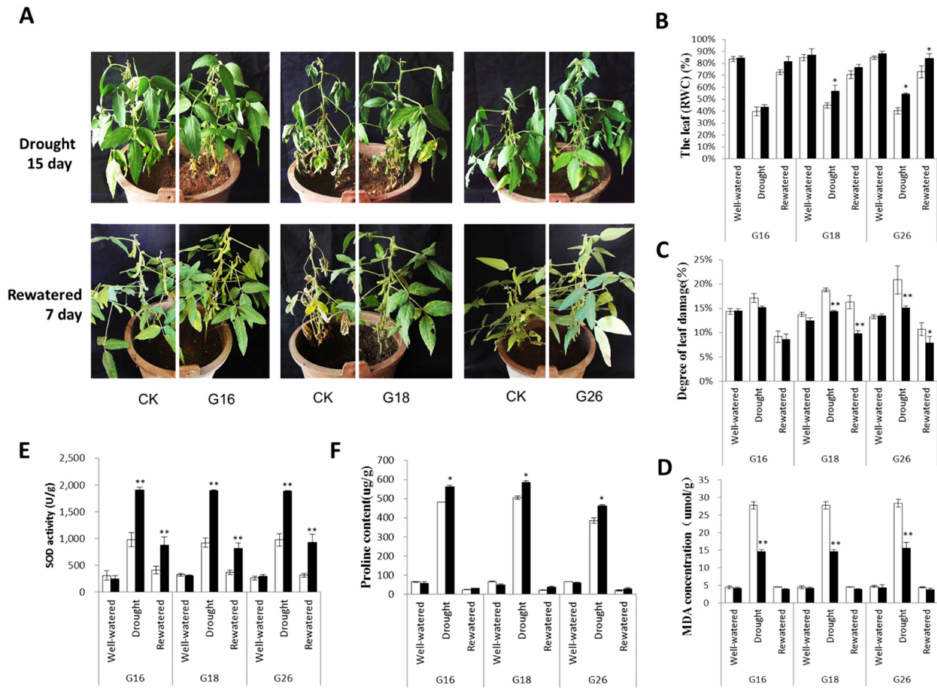
Figure 5. The GmNFYB17 transgenic soybean lines under drought treatment. ( A ) Morphology of transgenic and non-transgenic plants under drought conditions. Water was withheld for 15 d, and then plants were re-watered for 7 d. G16, G18 and G26 are transgenic lines; CK is soybean DN50; ( B , C )The leaf relative water content (RWC) and leaf damage of transgenic lines. G16, G18, G26 and non-transgenic control (CK) during the well-watered, drought and re-watered stage; ( D – F ) Comparison of physiological and biochemical indicators (MDA, SOD, Proline) between trans- genic and non-transgenic plants. *: p -value ≤ 0.05; **: p -value ≤